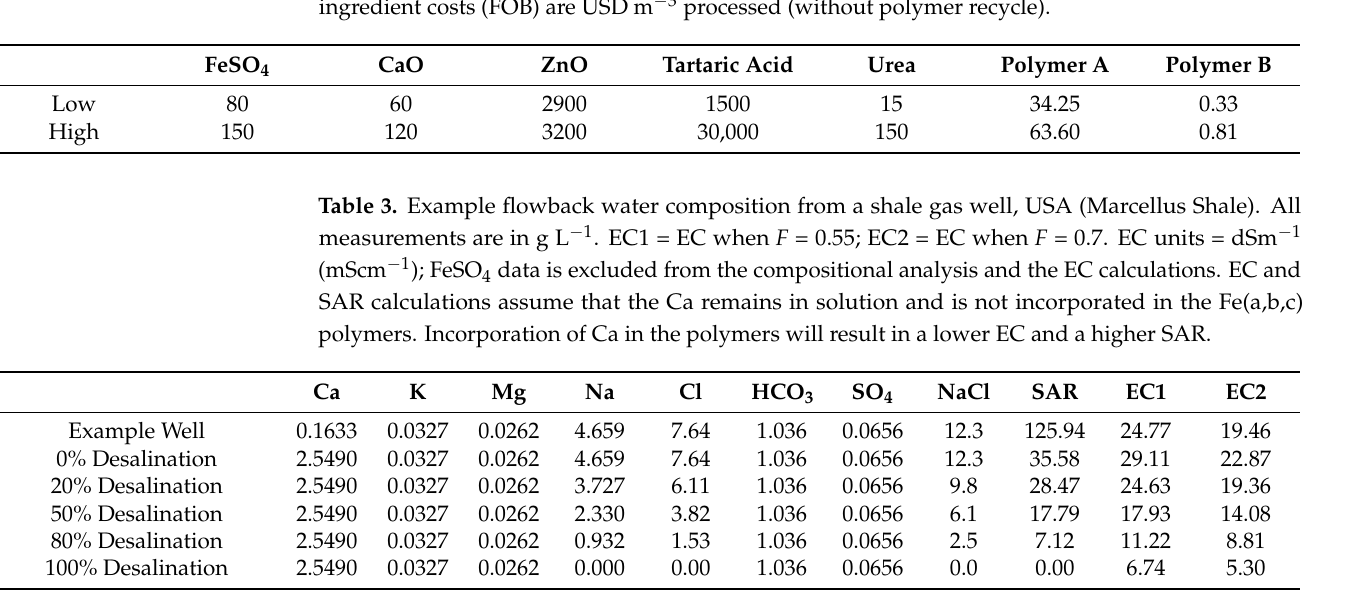
Table 2. Example costs. Material costs are FOB, USD t − 1 , Source—(www.alibaba.com, accessed on